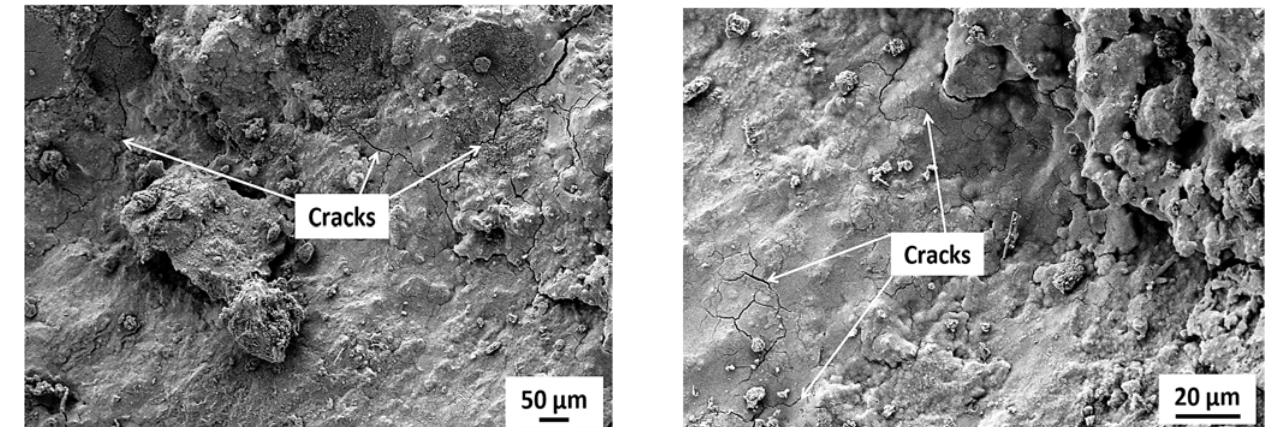
Figure 18. Micro-cracks in control specimens without RW exposed to ASR conditions. Figure 18. Micro ‐ cracks in control specimens without RW exposed to ASR conditions.